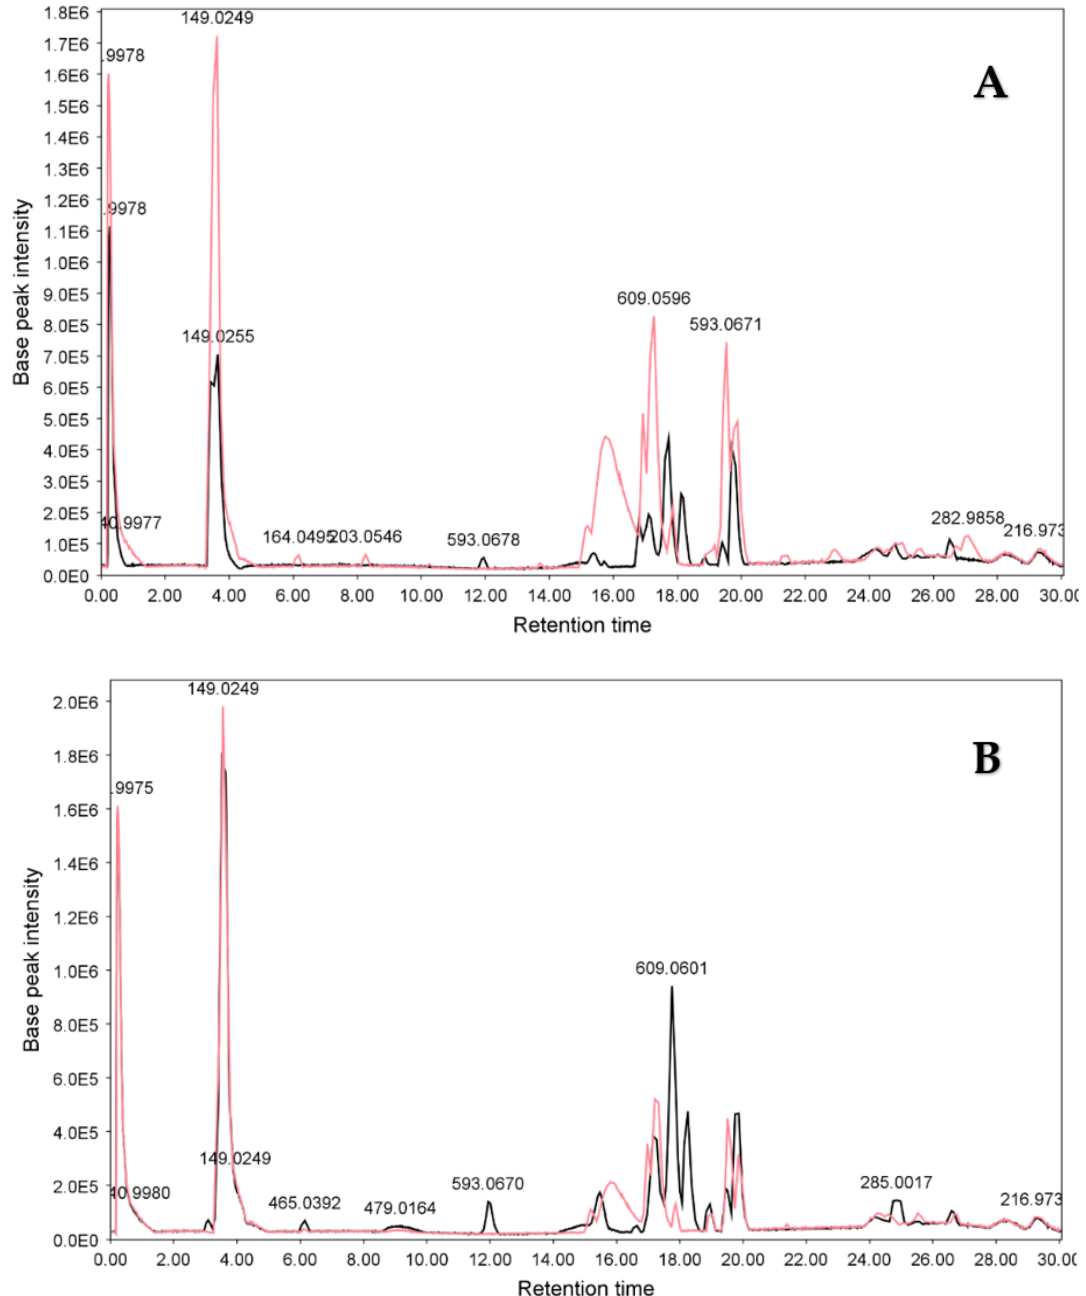
Figure 4. LC-MS chromatograms of ( A ) 100% and ( B ) 70% MeOH extracts of S. alexandrina (pink) and S. italica (black). For the separation, XBridge ® BEH C18 column (150 × 3.0 mm i.d., particle size 2.5 μm; Waters), gradient elution with MeOH and 0.2% aqueous acetic acid with a flow rate 0.2 cm 3 min − 1 was used. E5: 10 5 , E6: 10 6 . (For interpretation of the references to color in this figure legend, the reader is referred to the web version of this